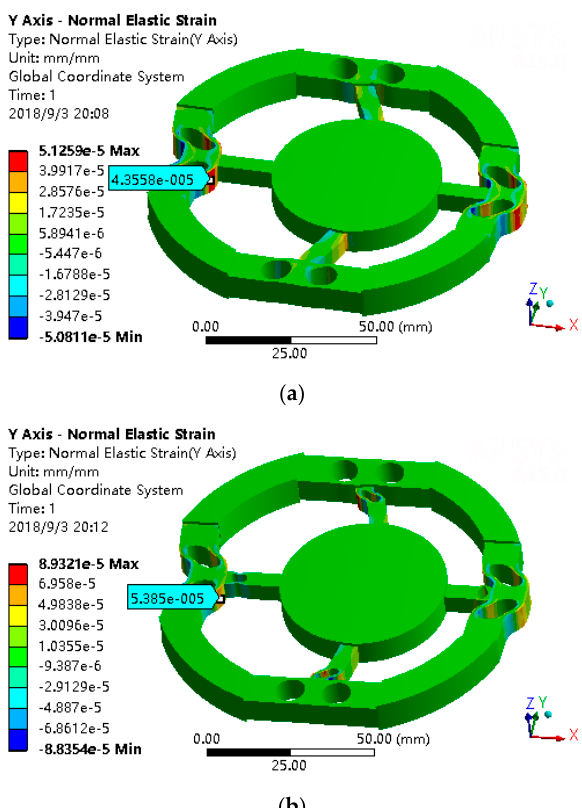
Figure 11. ( a ) The Y direction strain without hole under F x = 50 N. ( b ) The Y direction strain with hole under F x = 50